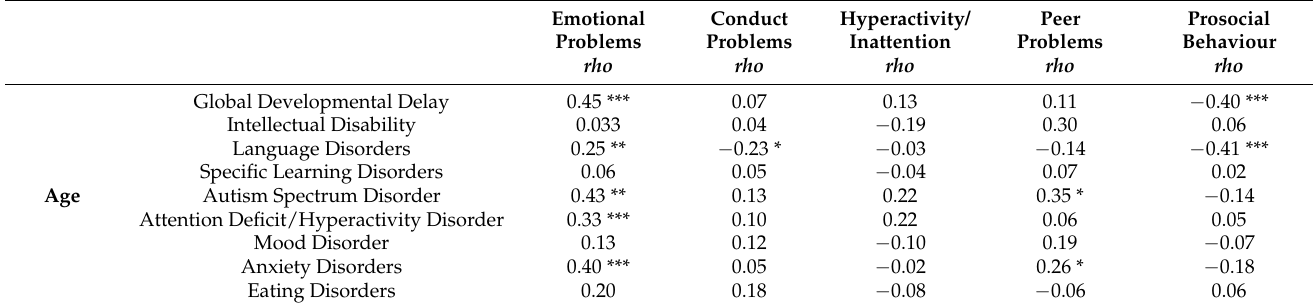
Table 2. Correlations (Spearman’s rho) between age and scores on the SDQ subscales for each diagnostic group.